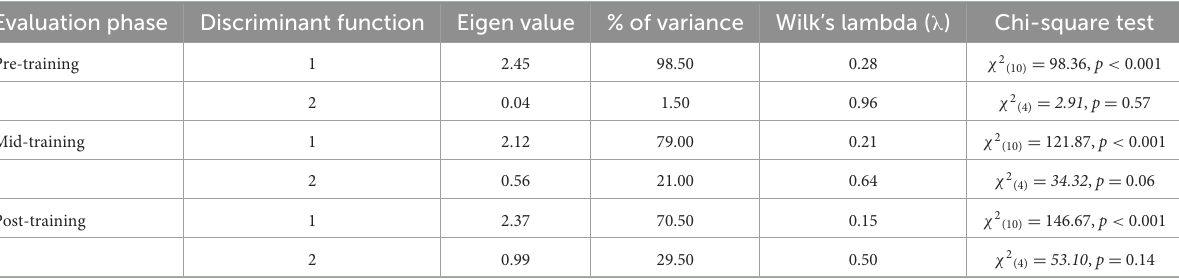
TABLE 3 Eigen values, Wilk’s lambda ( λ ), and percentage of variance for the standardized discriminant functions (DF 1 and DF 2 ) in pre-, mid-, and post-training evaluation